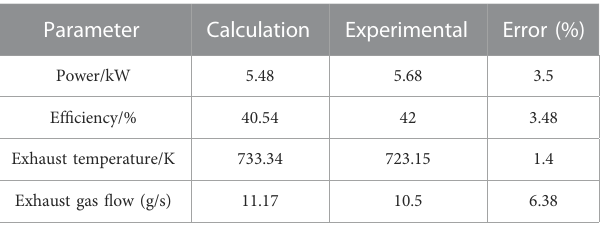
TABLE 2 Fuel cell model parameters. TABLE 3 Comparison between experimental data and calculated